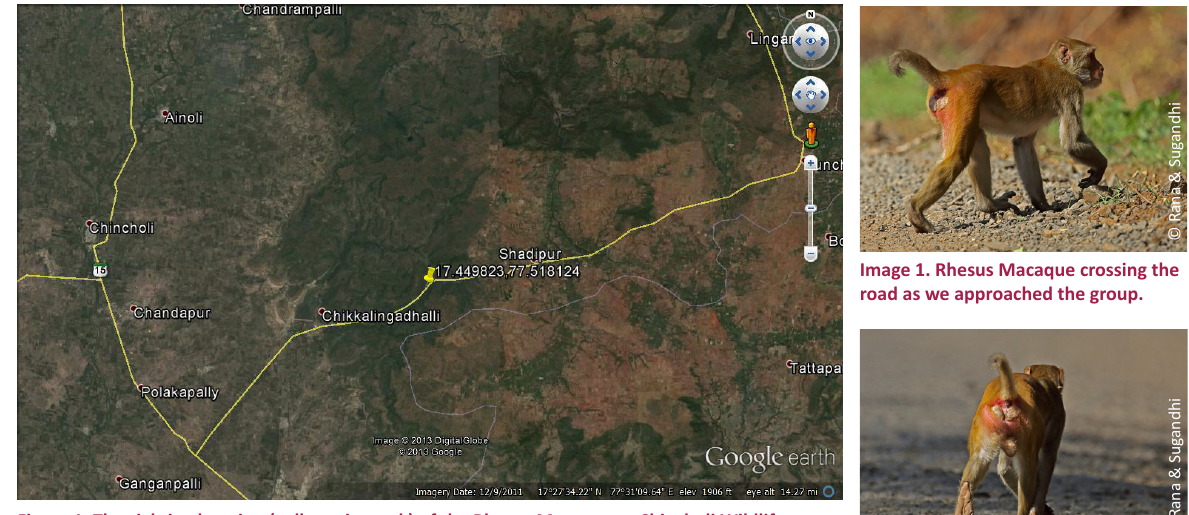
Figure 1. The sighting location (yellow pin mark) of the Rhesus Macaque at Chincholi Wildlife